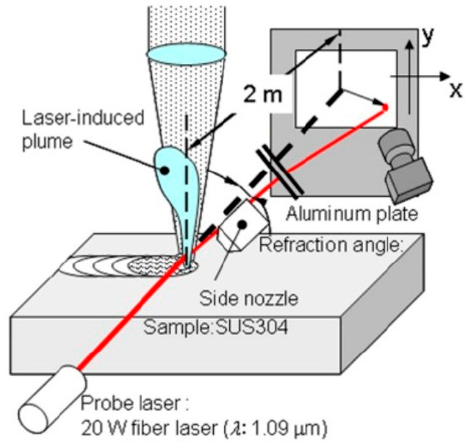
Figure 7. The schematic of studying the interaction between laser radiation and plasma plume using a probe laser. Reproduced with permission from [54], Taylor & Francis, 2008.